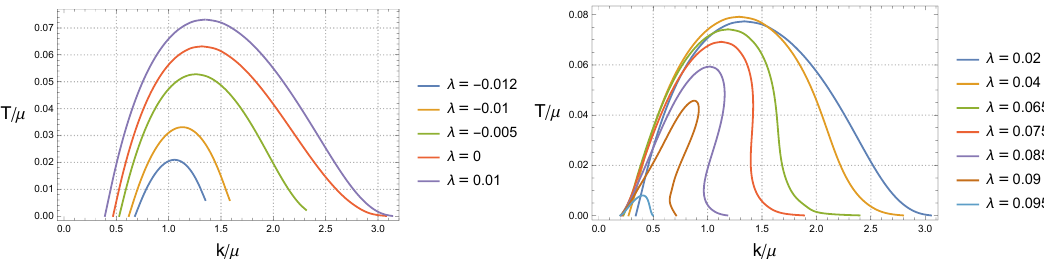
Figure 4 . The \bell curve" phase diagram at (cid:11) ’ 0 : 213 (i.e. (cid:11)=(cid:11) c ( (cid:21) = 0) = 1 : 47) for di(cid:11)erent values of (cid:21) . Note that when (cid:21) = (cid:0) 0 : 01 ; (cid:0) 0 : 012, the minimal temperature on the right side of bell-curve can not approach zero.